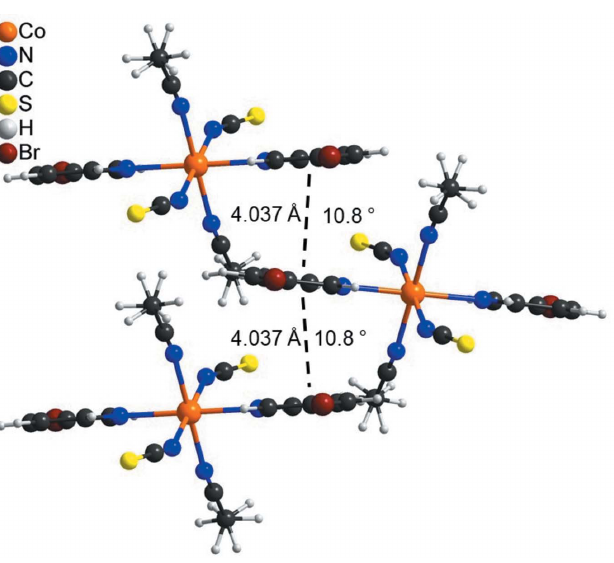
Figure 3 Crystal structure of the title compound showing the orientation of neighboring 3-bromopyridine rings. The distance between the centroids of the six-membered rings and the angles between the ring planes are shown. Please note that the methyl H atoms of the acetonitrile ligand are disordered.